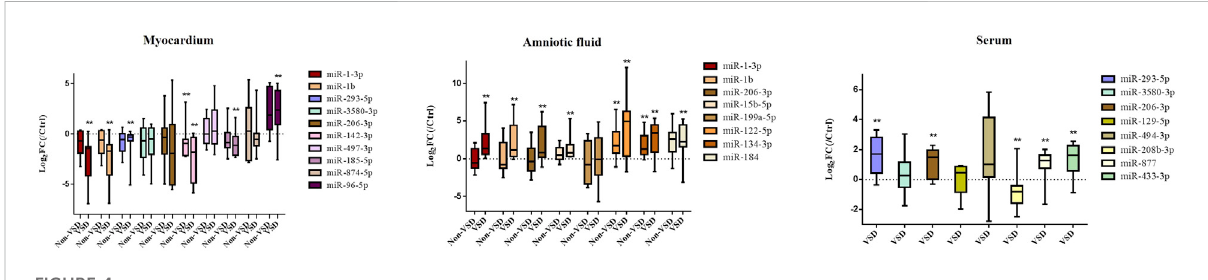
FIGURE 4 qRT – PCR veri fi ed the expression of DE-microRNAs. (Compared with NC group: * p < 0.05, ** p < 0.01. n = 9)